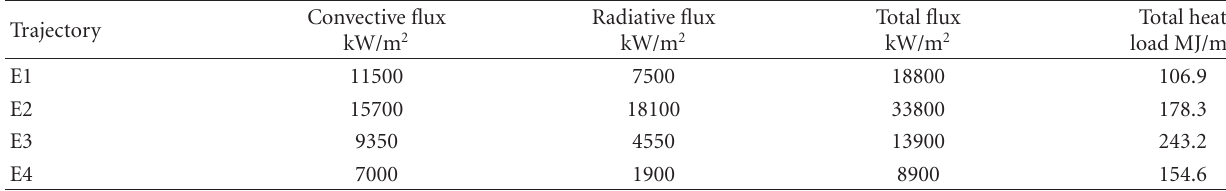
Table 5: Maximum heat fluxes for EVD mission [6].